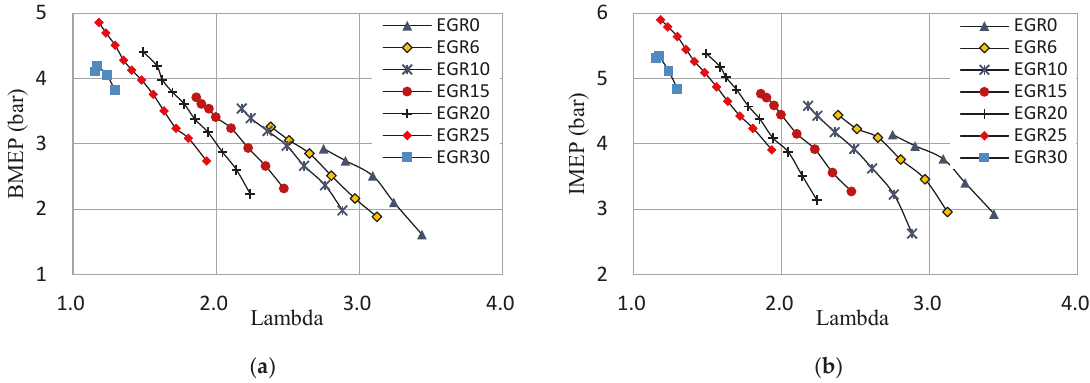
Figure 4. Effect of lambda on engine output with various EGR ratios: ( a ) BMEP; ( b ) IMEP.